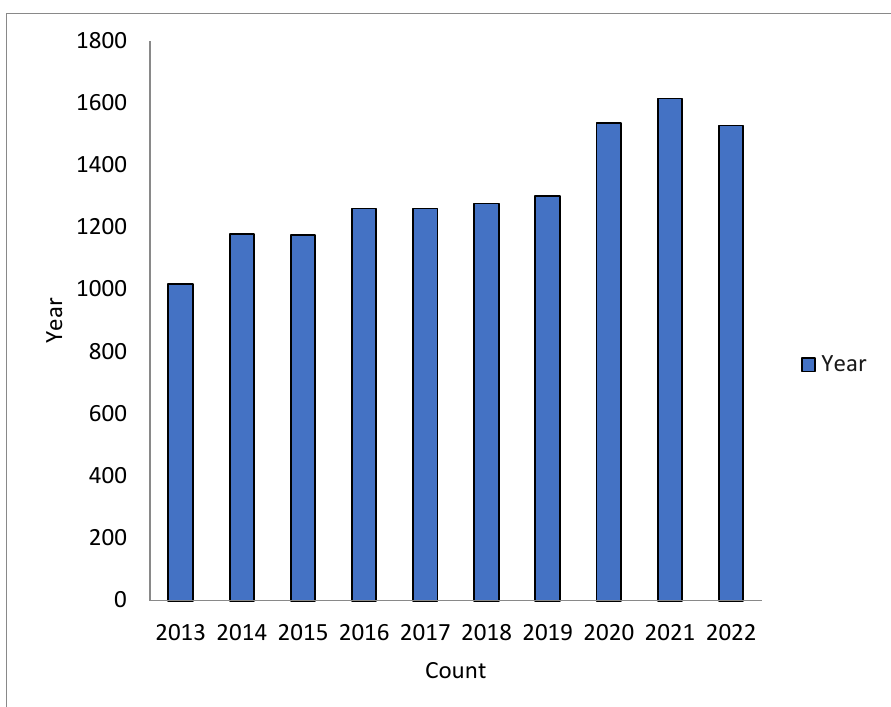
Figure 1. Total number of publications searched using PubMed (as on dated 21 March 2023, term searched “Tuberculosis”).